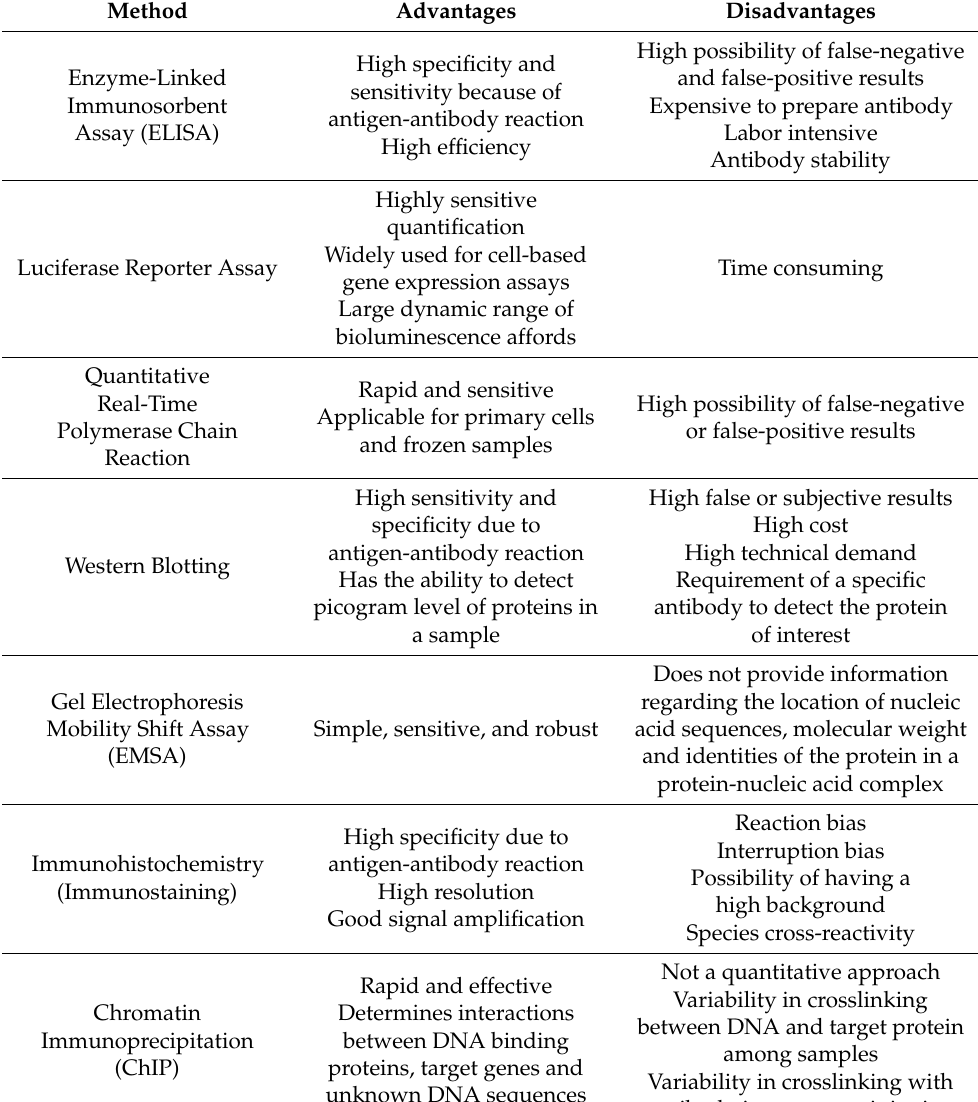
Table 1. Summary of the advantages and disadvantages of the methods used for NF- κ B